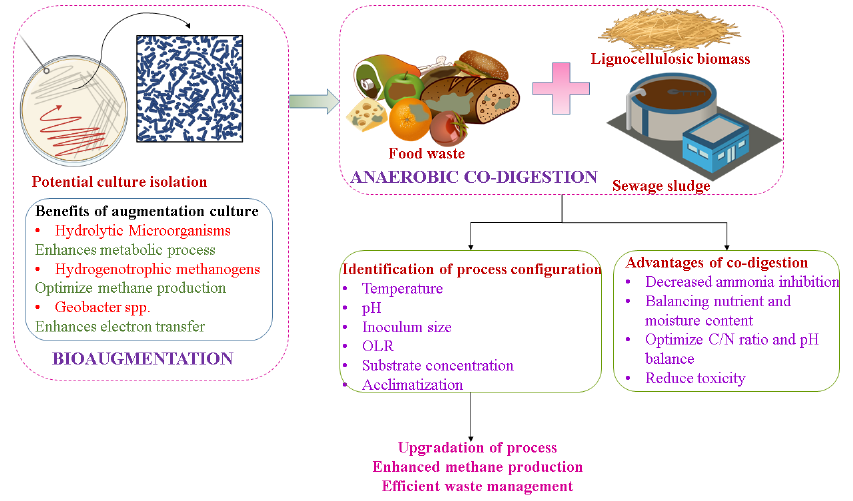
Figure 4. Innovative strategies for enhanced biogas production.